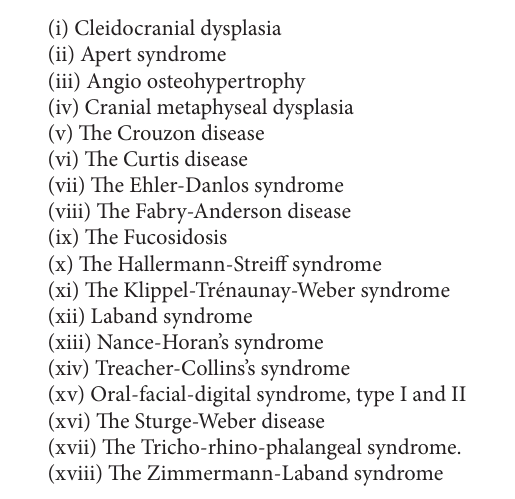
Box 1: Supernumerary teeth associated with syndromes.